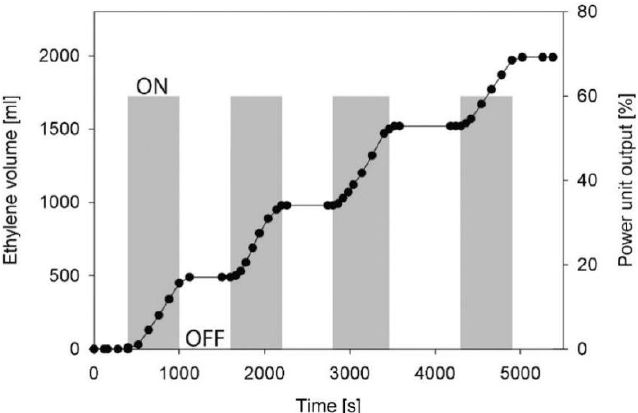
Figure 9. Demonstrates on/off control of the response by periodically switching the RF magnetic field [69].